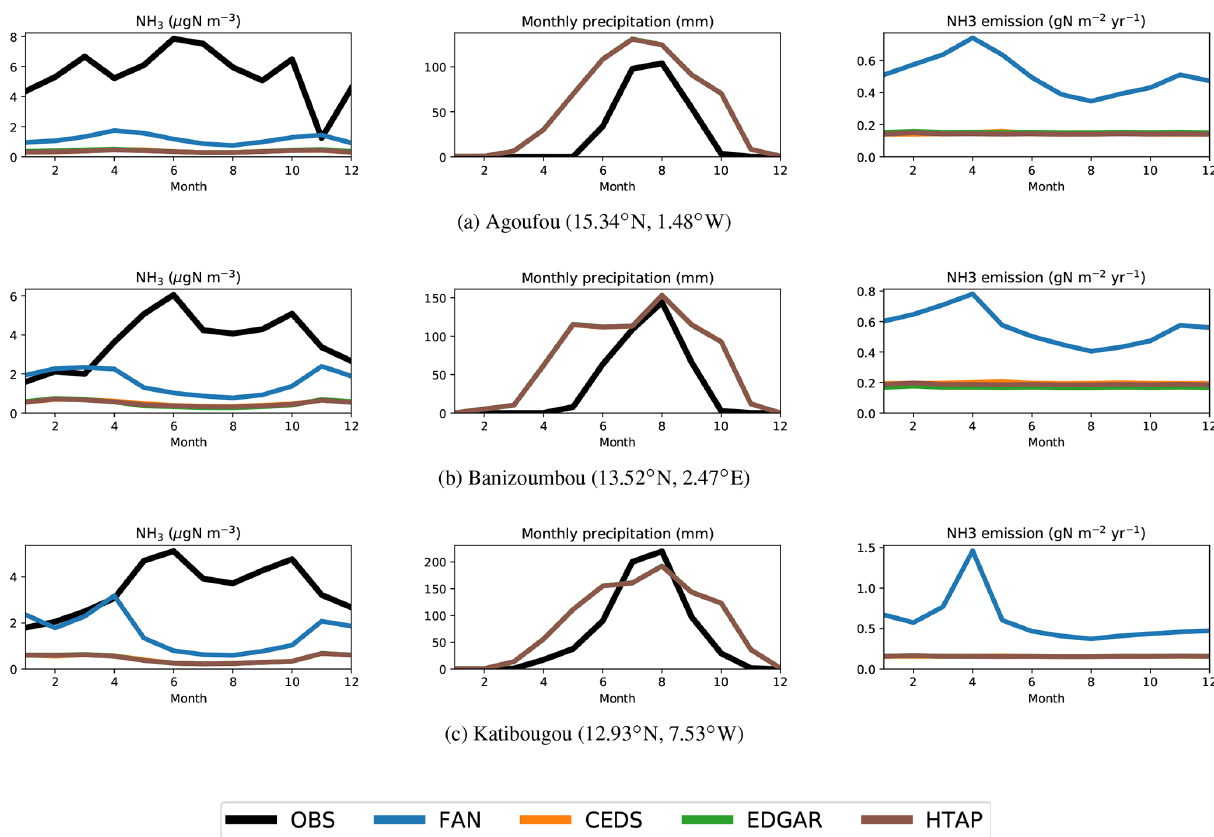
Figure 10. Simulated and observed ammonia concentration (µgNm − 3 ), monthly precipitation (mm; no difference between simulations) and the emission flux of ammonia (gNm − 3 yr − 1 ) on three dry savanna sites included in the INDAAF database.